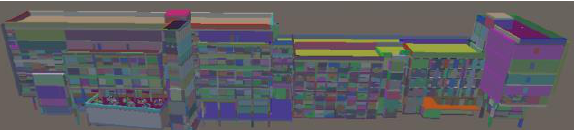
Figure 8 . Voxels rendering using